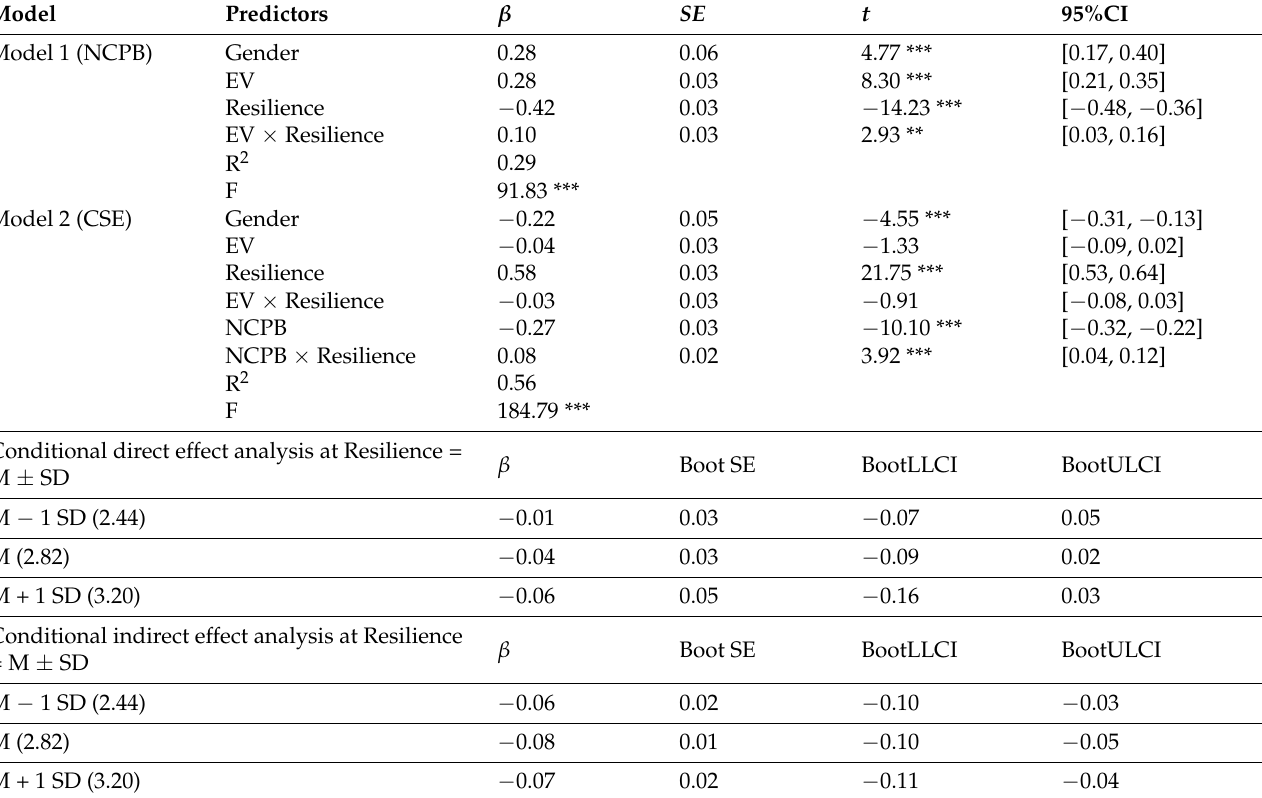
Table 2. Testing the moderated mediation